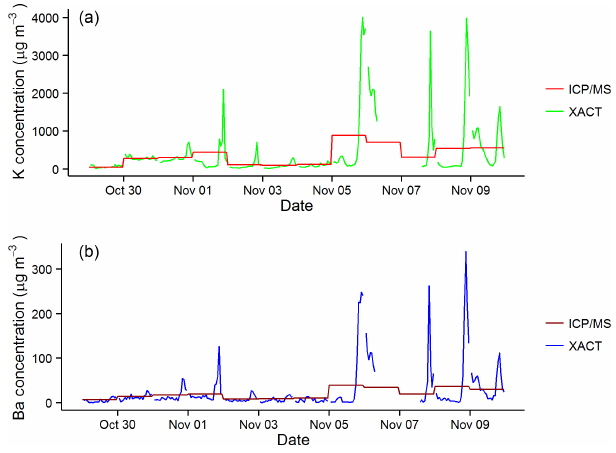
Figure 3. Time series of K (a) and Ba (b) concentration (µgm − 3 ) using hourly XACT and daily ICP-MS measurements at Maryle- bone Road,